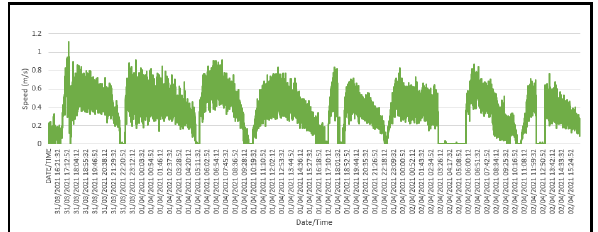
Figure 12. Graph above shows Speed Magnitude vs Time of the Full Day current data. The highest value of speed magnitude data within 2 days is 1.114 m/s, which was recorded on 31/03/2021 at 17:22:02 while the lowest speed is always 0 m/s Apart from that, an additional analysis is performed by dividing the observation day into Day 1 and Day 2. On Day 1, the fastest current measured was 1.114 m/s during high tide, with a speed direction of 74.9 degrees. The maximum speed current on Day 2 was 0.869 m/s with a speed direction of 77.8 degrees, which was lower than the highest speed current on Day 1. Both data occurred during a high tide.